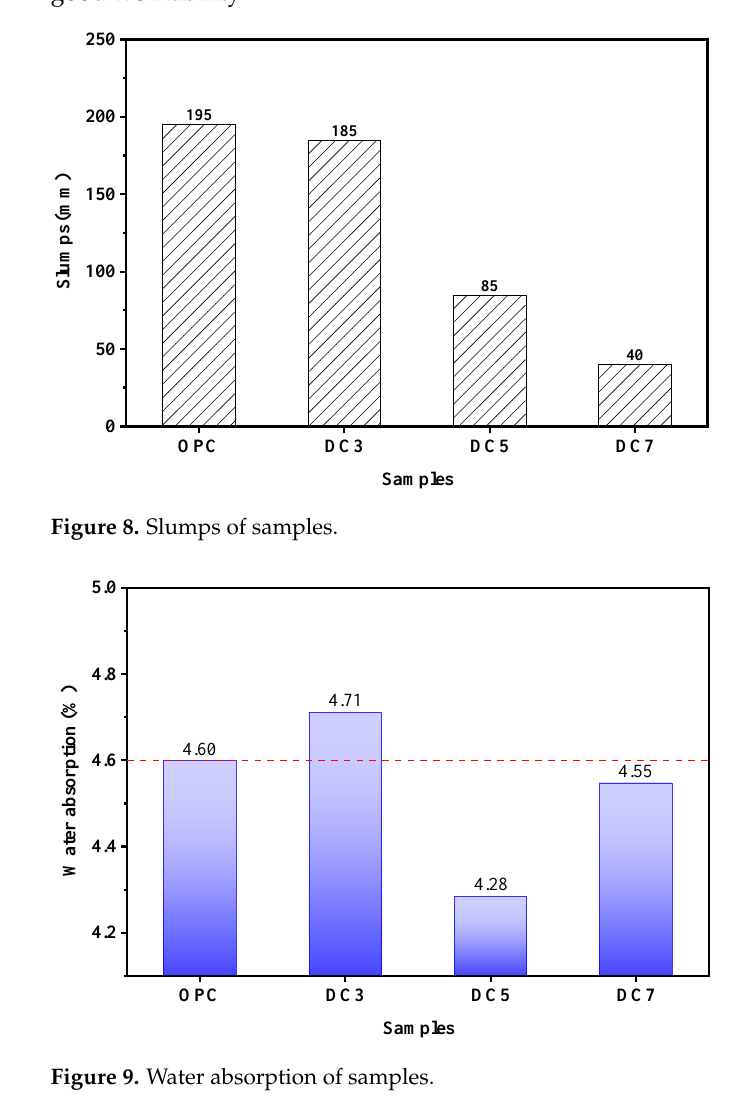
Figure 9. Water absorption of samples.